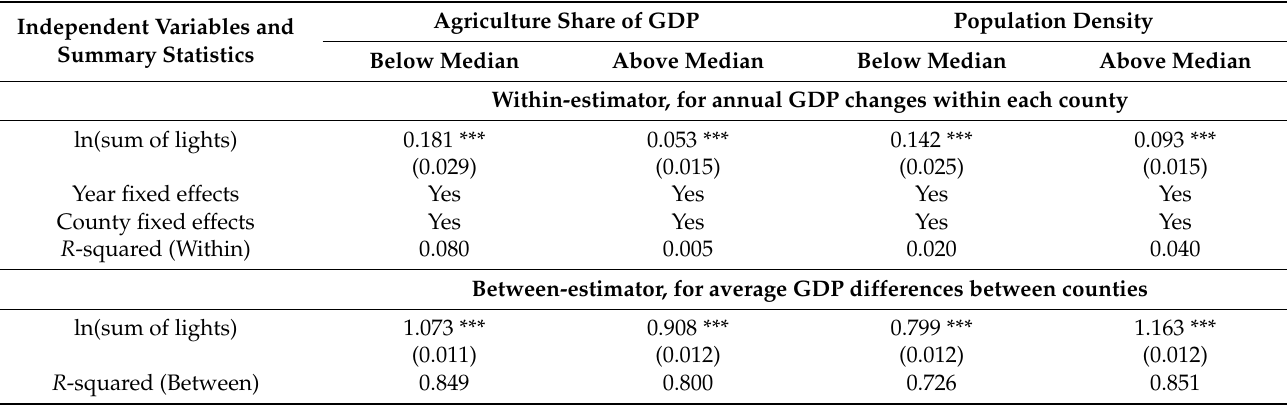
Table 8. Split-sample results for relationships between VIIRS V.2 VNL and county